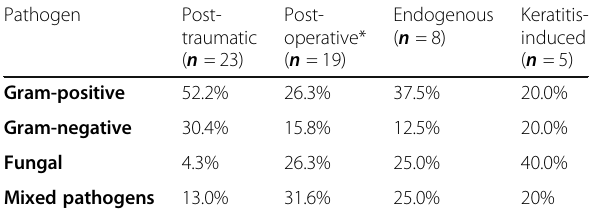
Table 9 Causative microorganisms among the different types of endophthalmitis in our study ( n = 55). Post-traumatic and endogenous cases had a higher prevalence of Gram-positive bacteria, while post-operative and keratitis-induced cases had a relatively high proportion of fungal infections